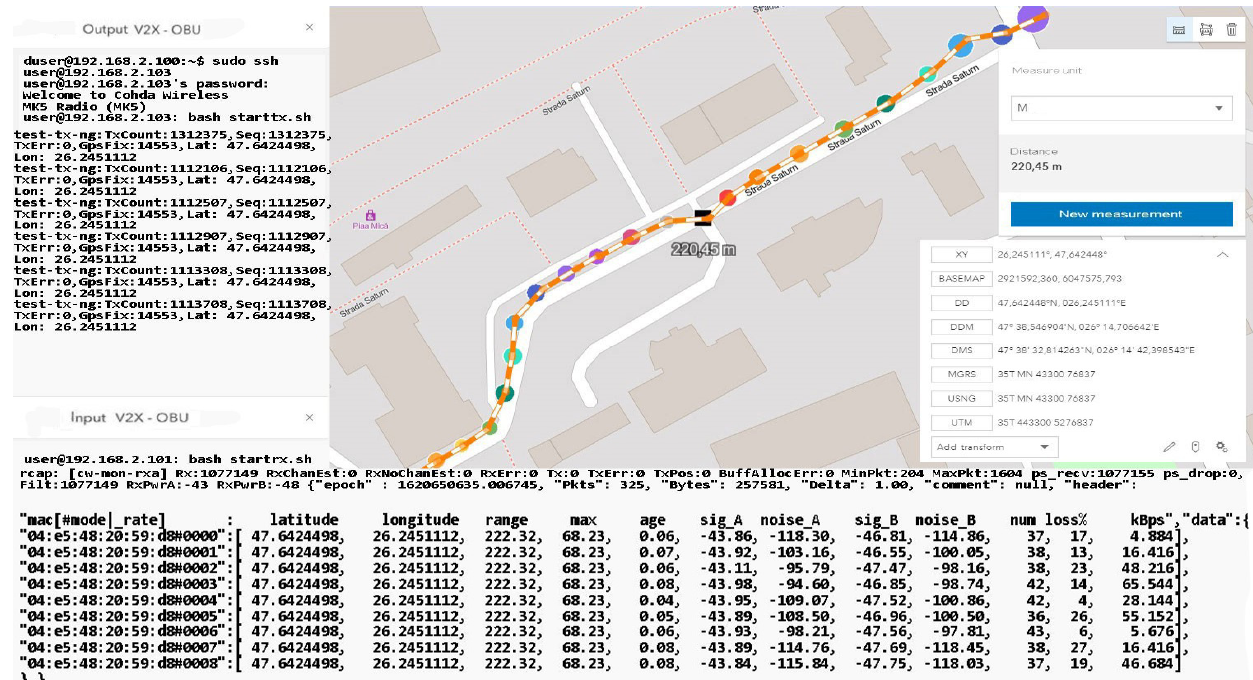
Figure 33. Simulated scenario at a distance of 220 m from the transmitter in a controlled environment.